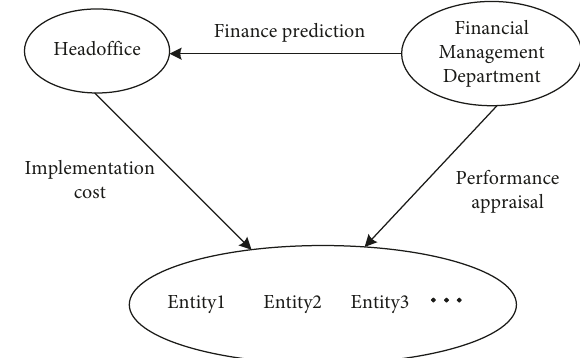
Figure 8: Diagram of the relationship between each responsibility